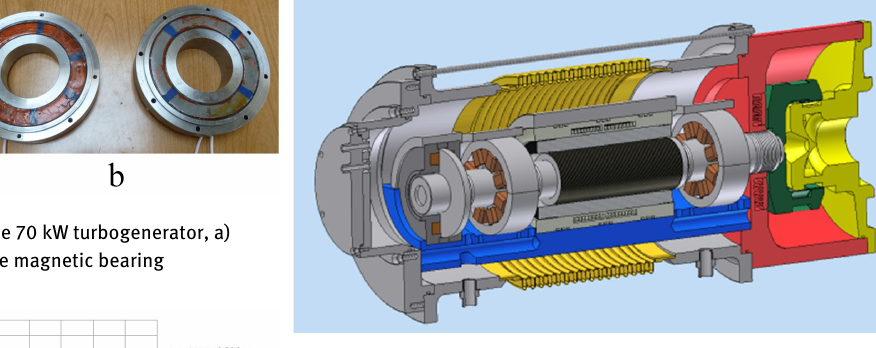
Figure 12: 3D model of the 70 kW turbogenerator equipped with a magnetic bearing system